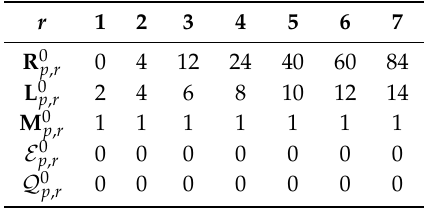
Table 2. Numbers of elements of R 0 p , r , L 0 p , r , M 0 p , r , E 0 p , r , Q 0 p , r .